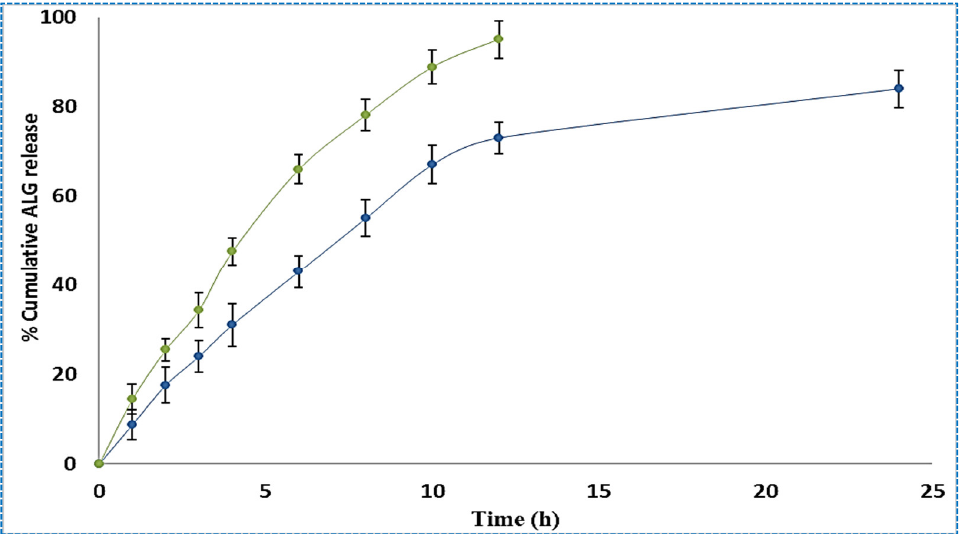
Figure 8. Comparative release profile of pure ALG and optimized ALG-NPs. Each study performed using three samples and data presented as mean ± SD.